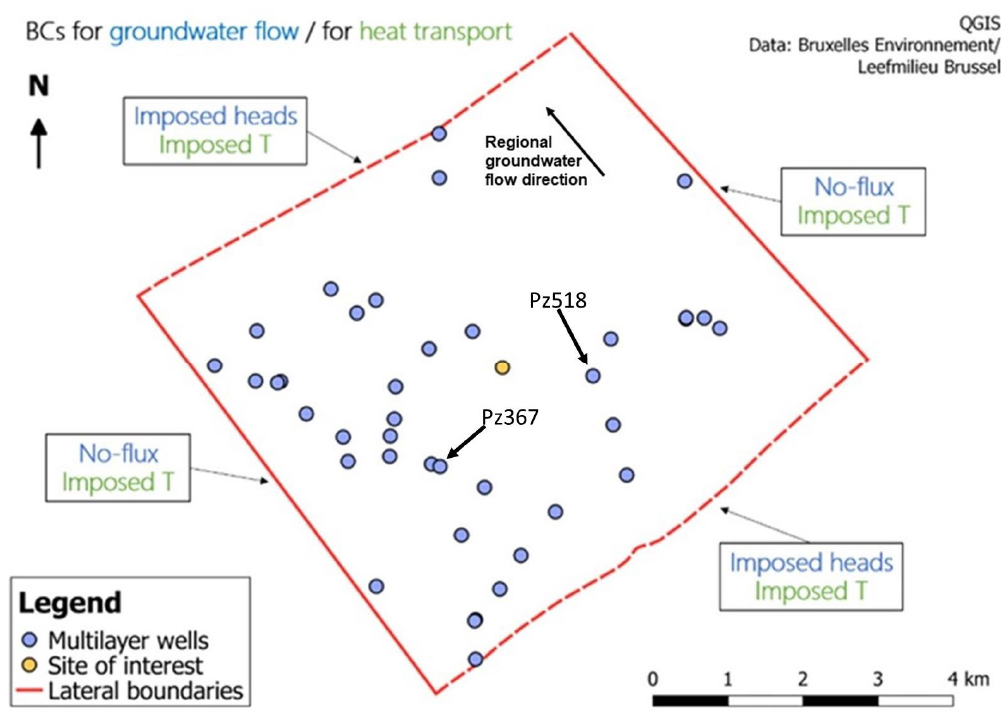
Figure 2. Lateral boundaries and boundary conditions for groundwater flow and heat transport simulations within the simplified regional map. Blue dots are existing wells and the arrow shows the regional groundwater flow direction.